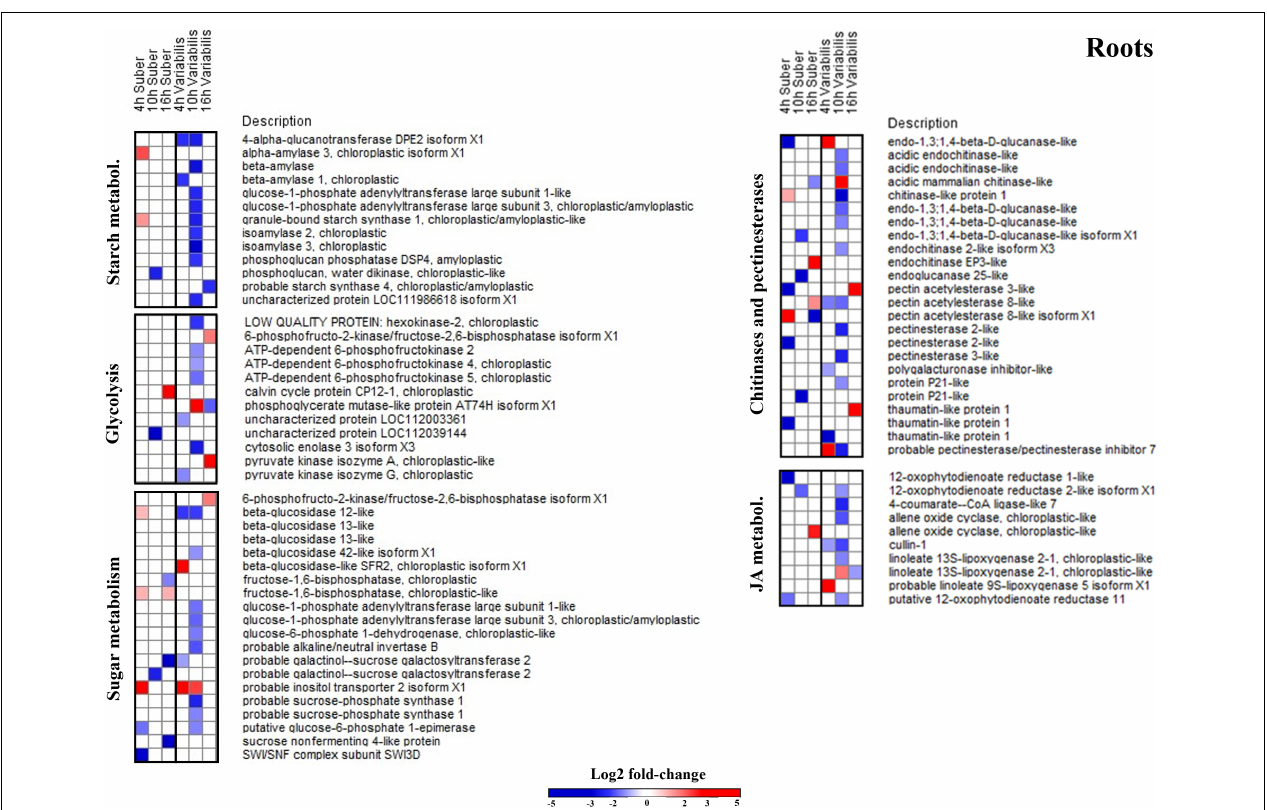
FIGURE 6 | Log2-fold changes (| FC| ≥ 2, p < 0.05) in the abundance of root proteins related to several relevant biological processes in Q. suber and Q. variabilis 4, 10, and 16 h after inoculation with P. cinnamomi .